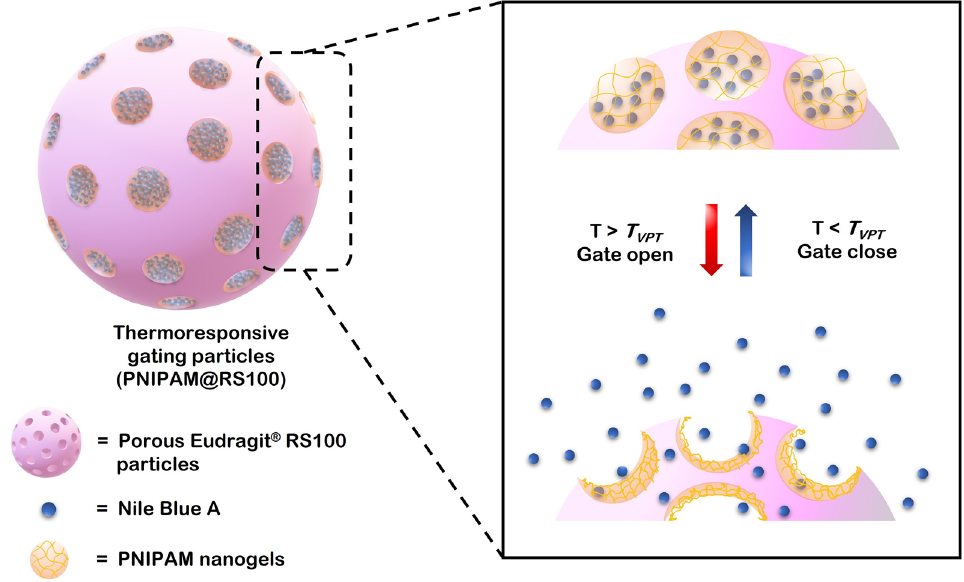
Figure 1. Design of thermoresponsive gating particles and the controlled release mechanism of thermally- sensitive PNIPAM